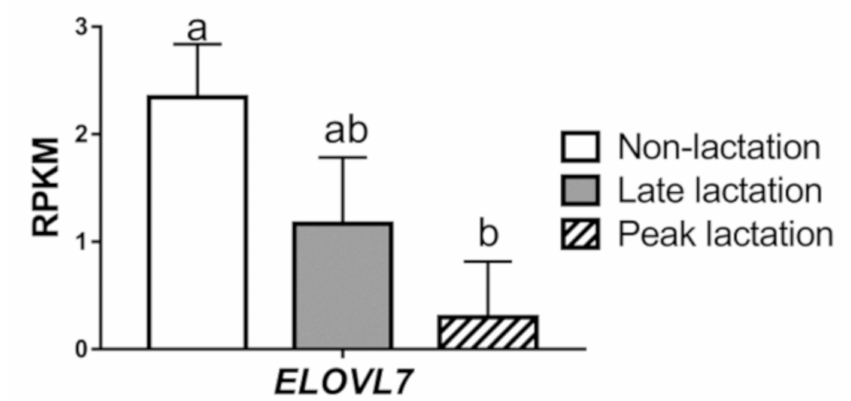
Figure 1. The mRNA abundance of elongation of very-long-chain fatty acid-like fatty acid elongase 7 ( ELOVL7 ) in goat mammary gland tissues. Values are means ± SEM for 3 individual goats. Significance of RNA expression of ELOVL7 in mammary gland tissue across di ff erent stages of lactation was determined by one-way ANOVA. The di ff erent letters denote significant ( p < 0.05) di ff